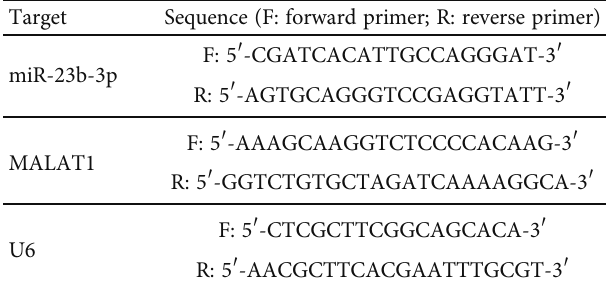
Table 1: RT-qPCR primer